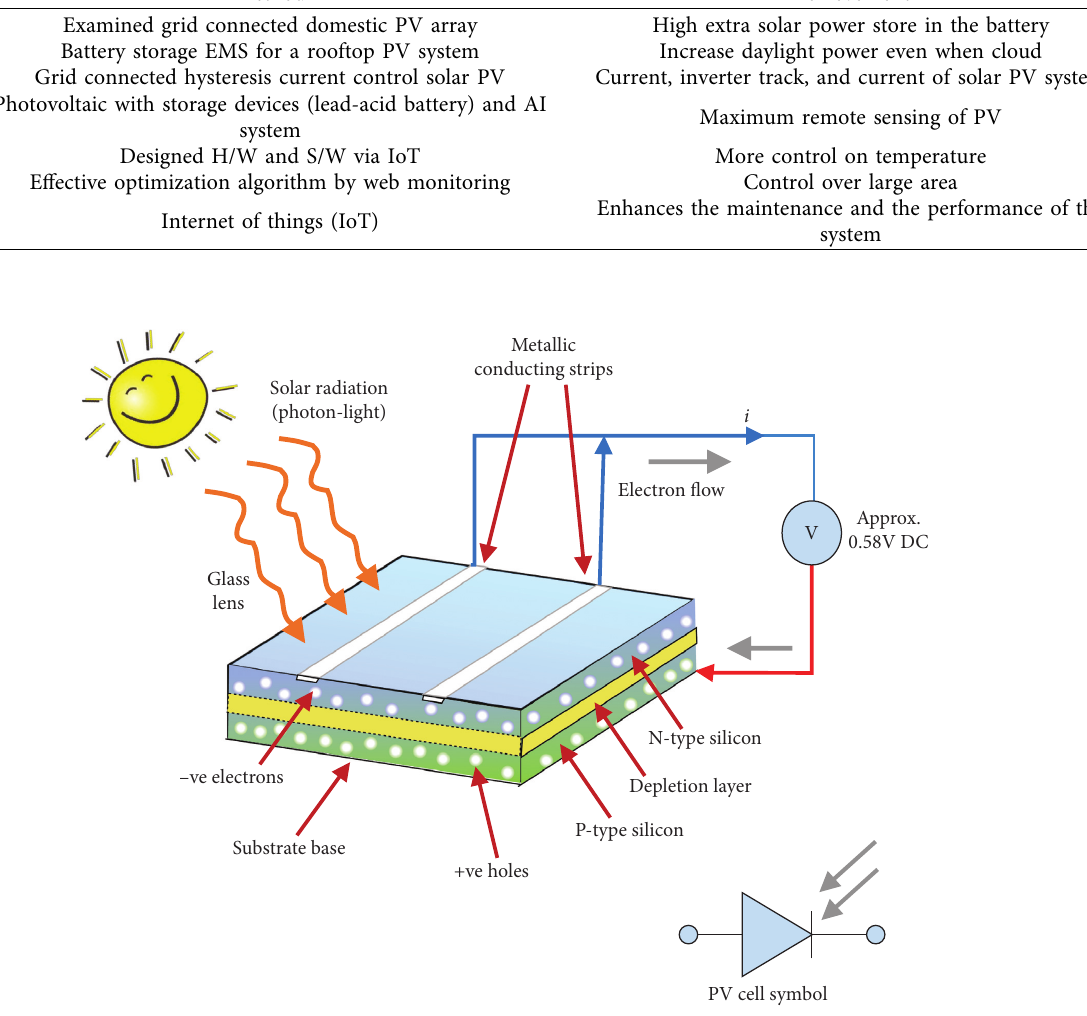
Figure 1: How PV converts light to electricity?